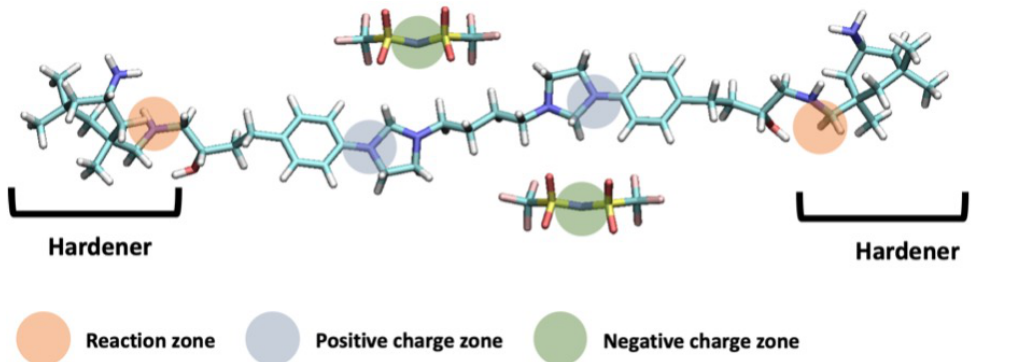
Figure 1. A representation of the reaction between one cation and two hardeners as shown in full orange circles. The negative charge zone on the anions and positive charge zone on the cations are shown as full green and grey circles, respectively.